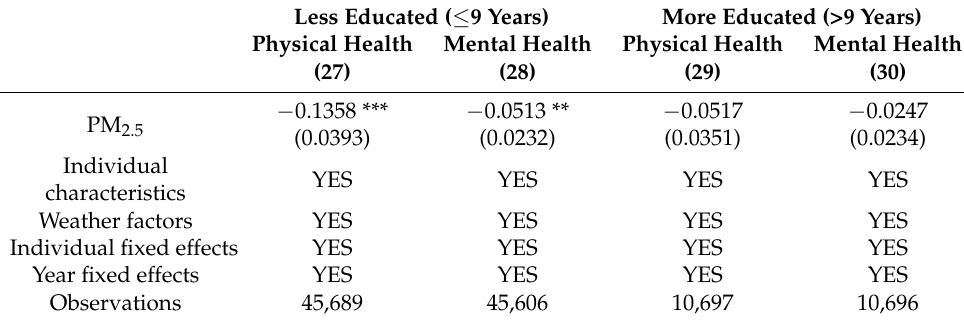
Table 9. Heterogeneity effects with